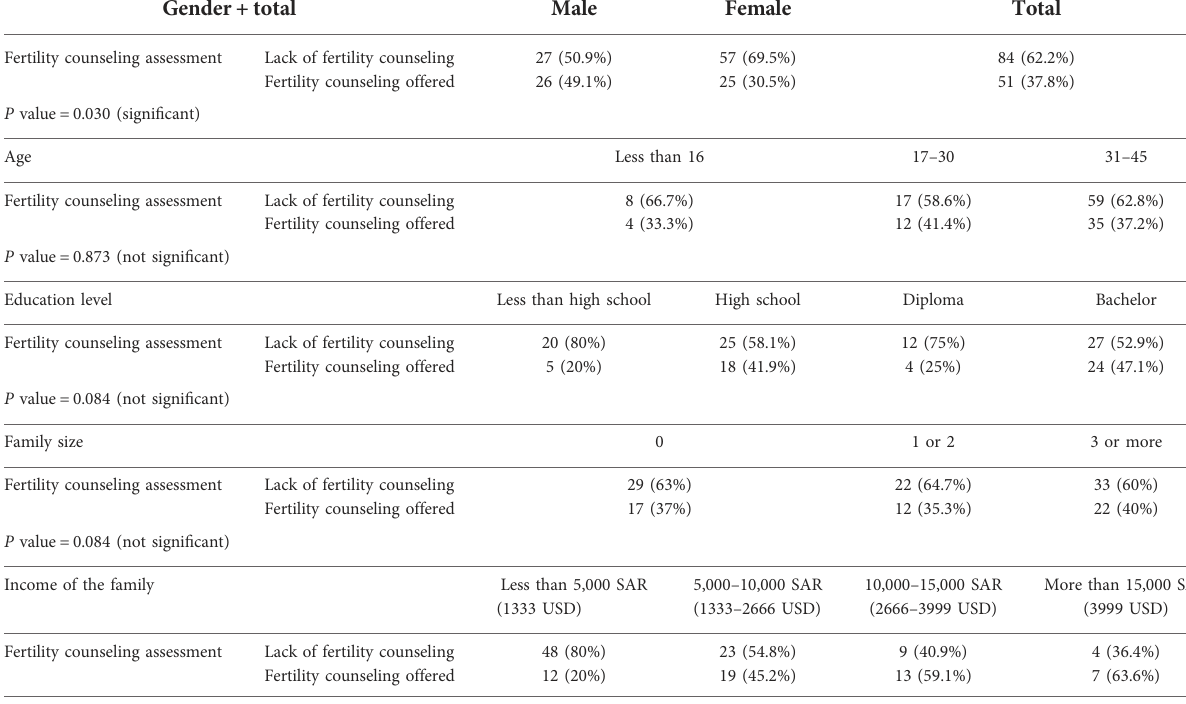
TABLE 6 Assessment of the fertility counseling provided by physicians.